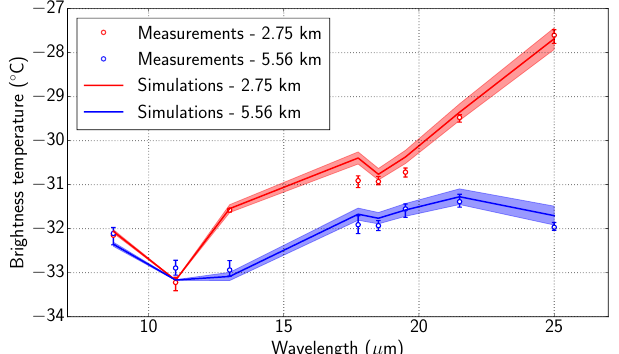
Figure 7. Measured and simulated spectral brightness temperatures at the two altitudes where Polar 6 levelled during 11 April flight. At both levels four consecutive measurements were taken. Their means and ranges are indicated by the circles and error bars, respectively. The shaded areas indicate the uncertainties in the simulations due to uncertainties on the measured temperature and relative humidity profiles, namely 0.3K and 2.5%.